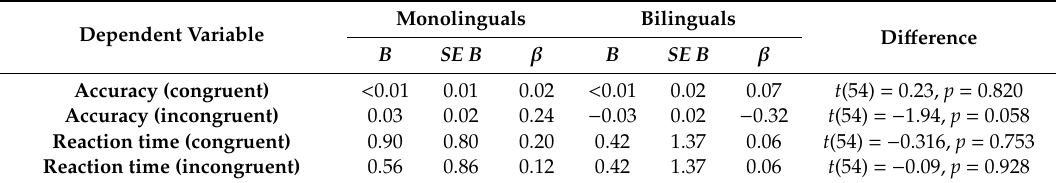
Table A3. Regression coe ffi cients and t -statistics of the relationship between trait anxiety and the dependent variables (Simon